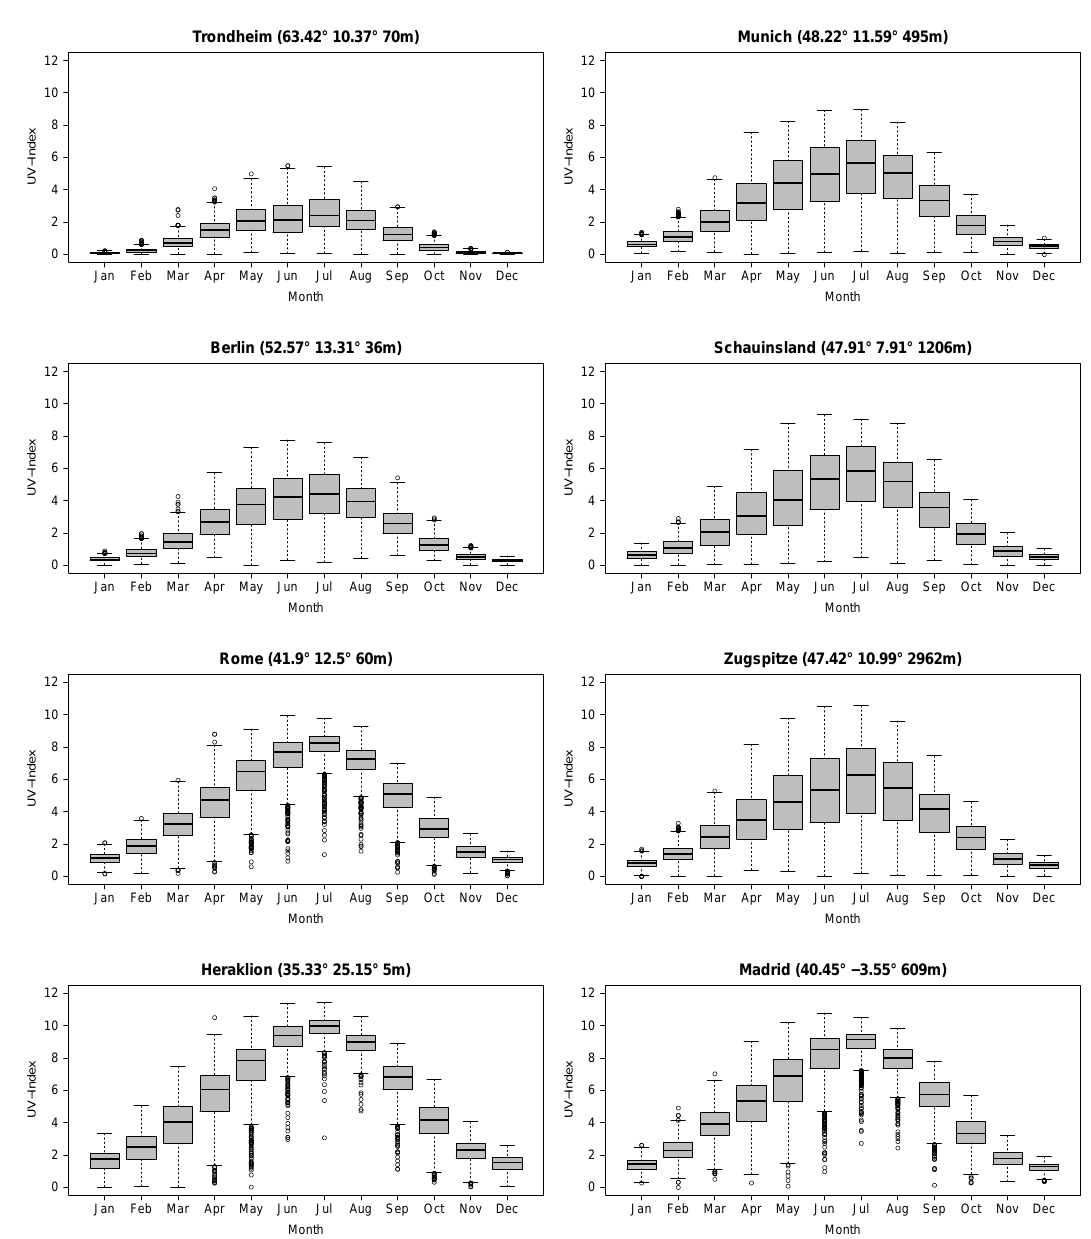
Figure 6. Monthly box plots of noontime UVI all − sky over the time period 1983–2015 for each location based on satellite